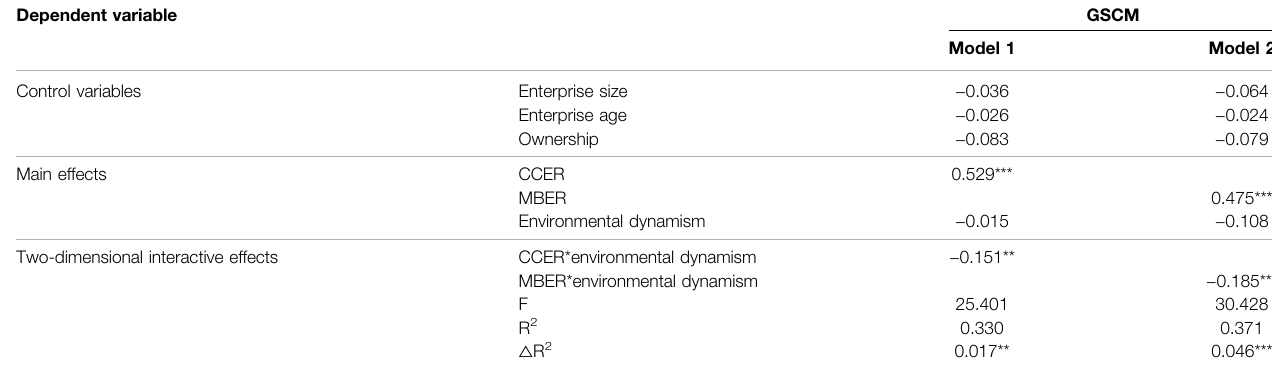
TABLE 7 | Regression analysis results on the regulating effect on the relationship between ER and GSCM. Dependent variable